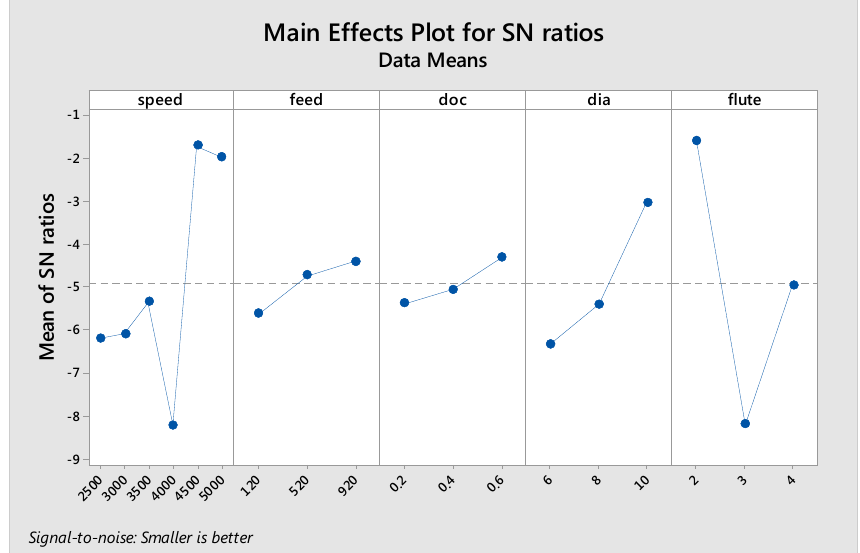
Fig. 7.b. Main effect plot for SN ratio.